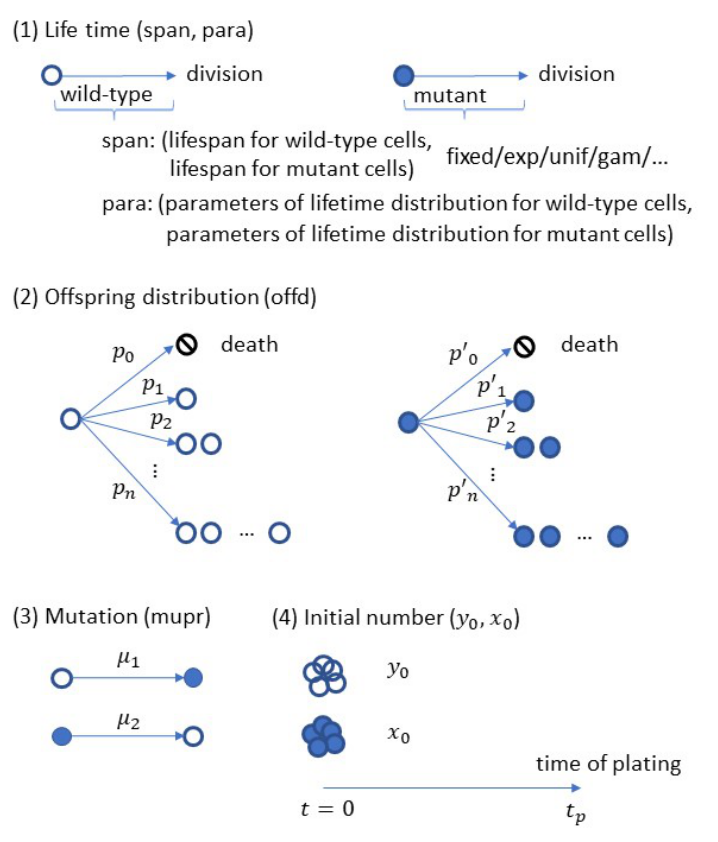
Figure 2. Input of the SimuBP algorithm. Algorithm 1 The SimuBP algorithm for simulating cell population with mutations based on a